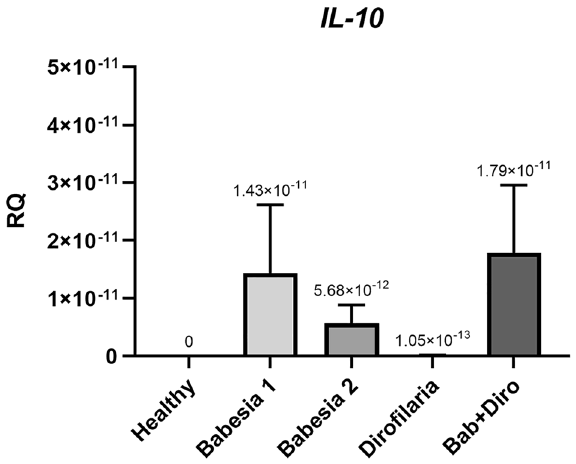
Figure 3. Relative expression of interleukin 10 ( IL-10 ) in healthy dogs infected with B. canis , D. repens , and co-infected with B. canis and D. repens (Bab +